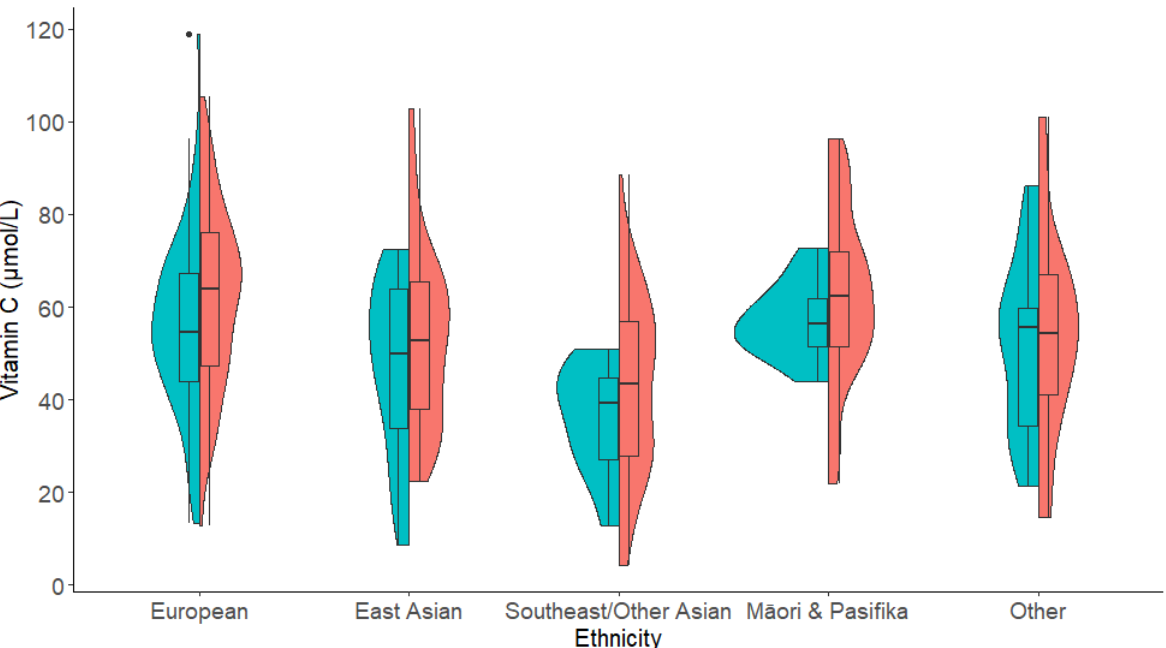
Figure 2. Violin plot showing the vitamin C levels for each ethnicity by gender (male = blue (left) and female = red (right)). Overlaid boxplots show median vitamin C levels for each gender for each ethnicity, interquartile range, and any outliers. See Supplementary Table S2 for the mean plasma vitamin C levels for each ethnicity by gender subgroup. Europeans ( n = 206, 80 male, 126 female), East Asians ( n = 68, 17 male, 51 female), Southeast/Other Asian ( n = 61, 9 male, 52 female), M ā ori & Pasifika ( n = 38, 10 male, 28 female), other ethnicities ( n = 46, 19 male, 27 female).